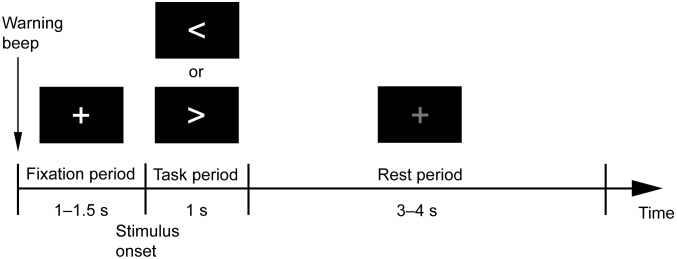
Experimental design.Each trial began with a warning beep. Following the beep, a white cross was presented for a variable duration of 1–1.5 s. Subjects were instructed to fixate on it. Then a cue stimulus, “>” or “<”, was presented for 1 s to instruct subjects to initiate the task. Following the cue stimulus, a gray cross was presented for a variable duration of 3–4 s. Subjects were allowed to blink only during this period.